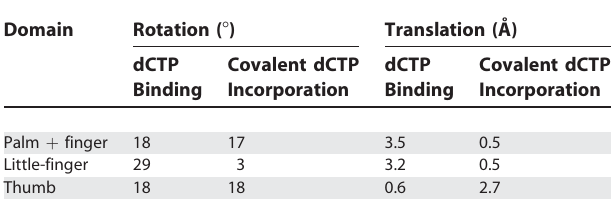
Table 3. Rotation and Translation of Dpo4 Domains with Respect to DNA for the Preinsertion Binary to Insertion Ternary Step (dCTP Binding) and for the Insertion Ternary to Post- insertion Binary Step (dCTP Incorporation).